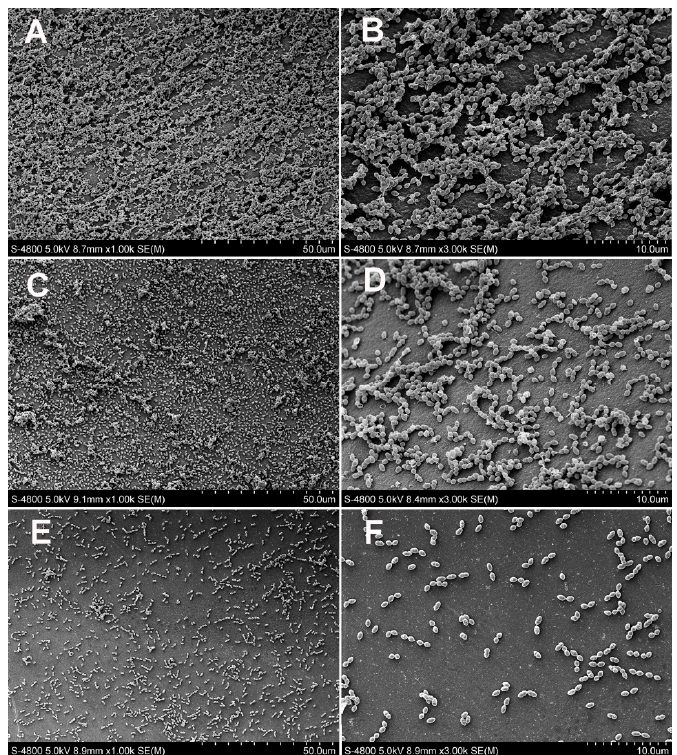
Figure 2. The scanning electron micrographs (magnification 1000× and 3000×) of Streptococcus mutans biofilms on the specimens in the control group and in the EGCG groups: SB 2 ( A , B ); EGCG 200 ( C , D ); EGCG 400 ( E , F ); and EGCG 600 (G, H ). Dense biofilms have formed on the surface of the SB 2 specimens. EGCG 200, 400, and 600, epigallocatechin-3-gallate at 200 µg/mL, 400 µg/mL, and 600 µg/mL, respectively; EGCG-3Me 200, 400, and 600, epigallocatechin-3- O -(3- O -methyl)-gallate at 200 µg/mL,